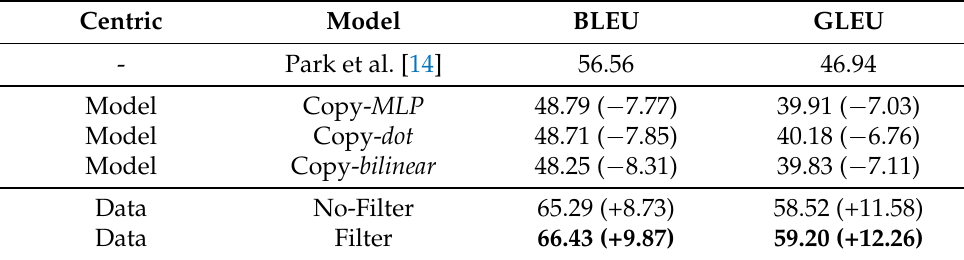
Table 1. Verification of data and model-centric